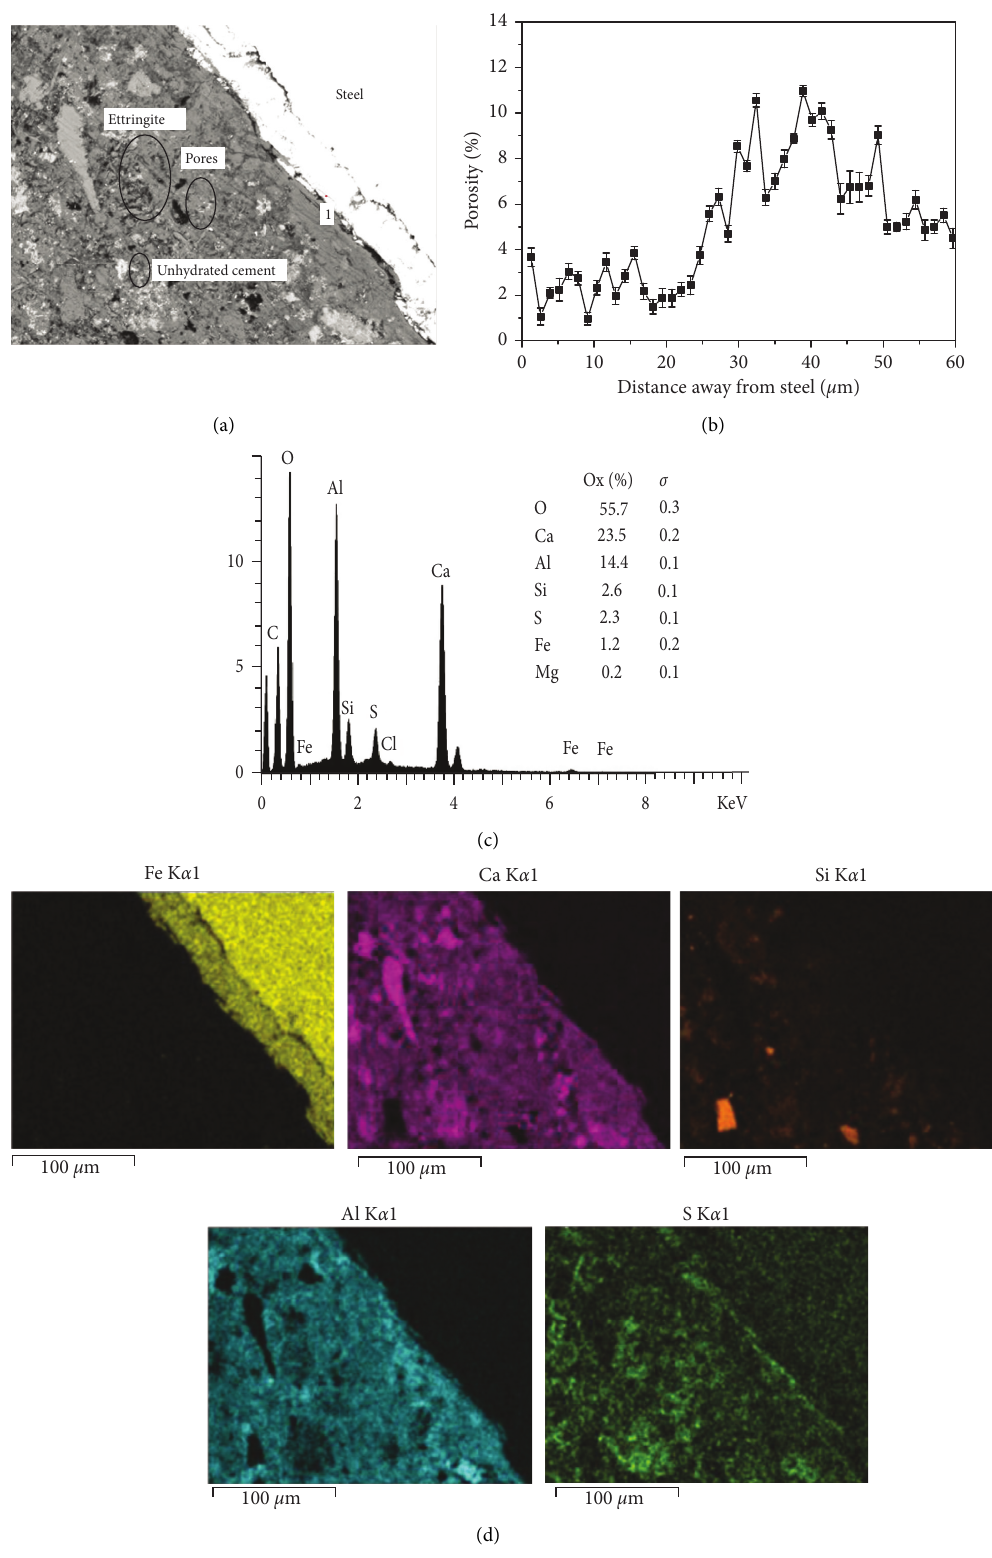
Figure 4: Microstructure of steel reinforced CSA concrete aged for 28 d: (a) microstructure of steel reinforced CSA concrete, (b) porosity at ITZ, (c) EDXA spot analysis of Point ‘1’ at ITZ, and (d) elemental mappings of Fe, Ca, Si, Al, and